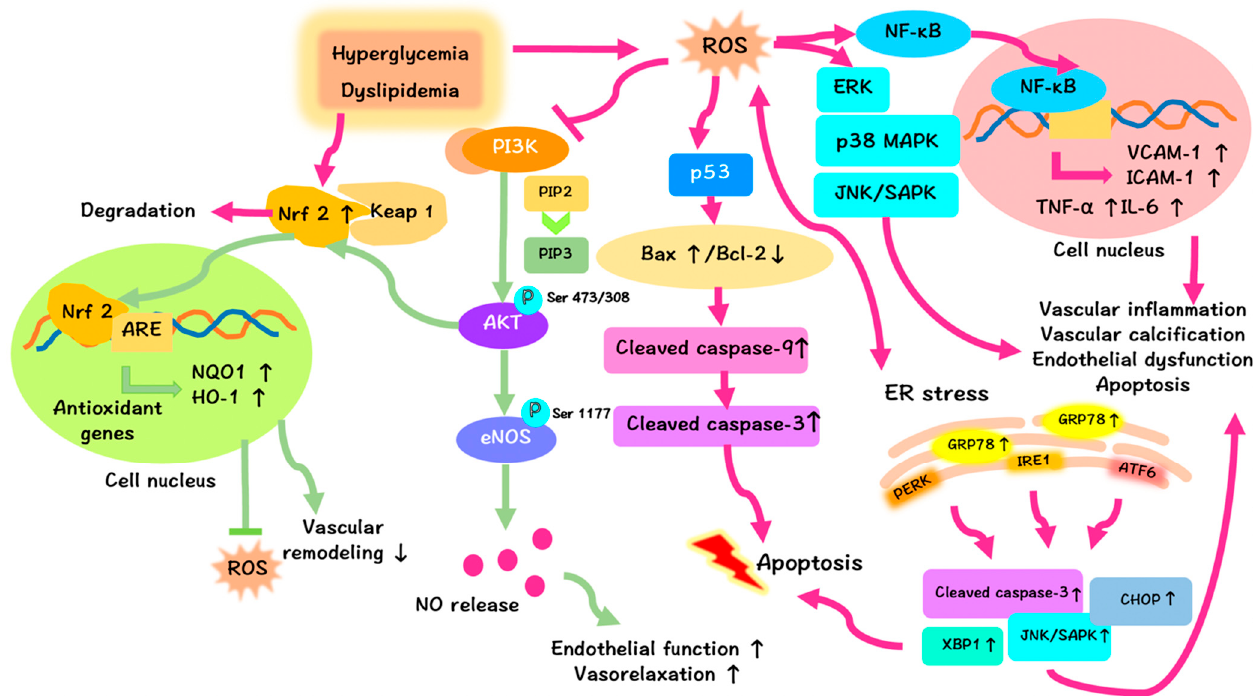
Figure 2. Interaction of oxidative stress with various signaling pathways, leading to vascular dys- function in diabetes.